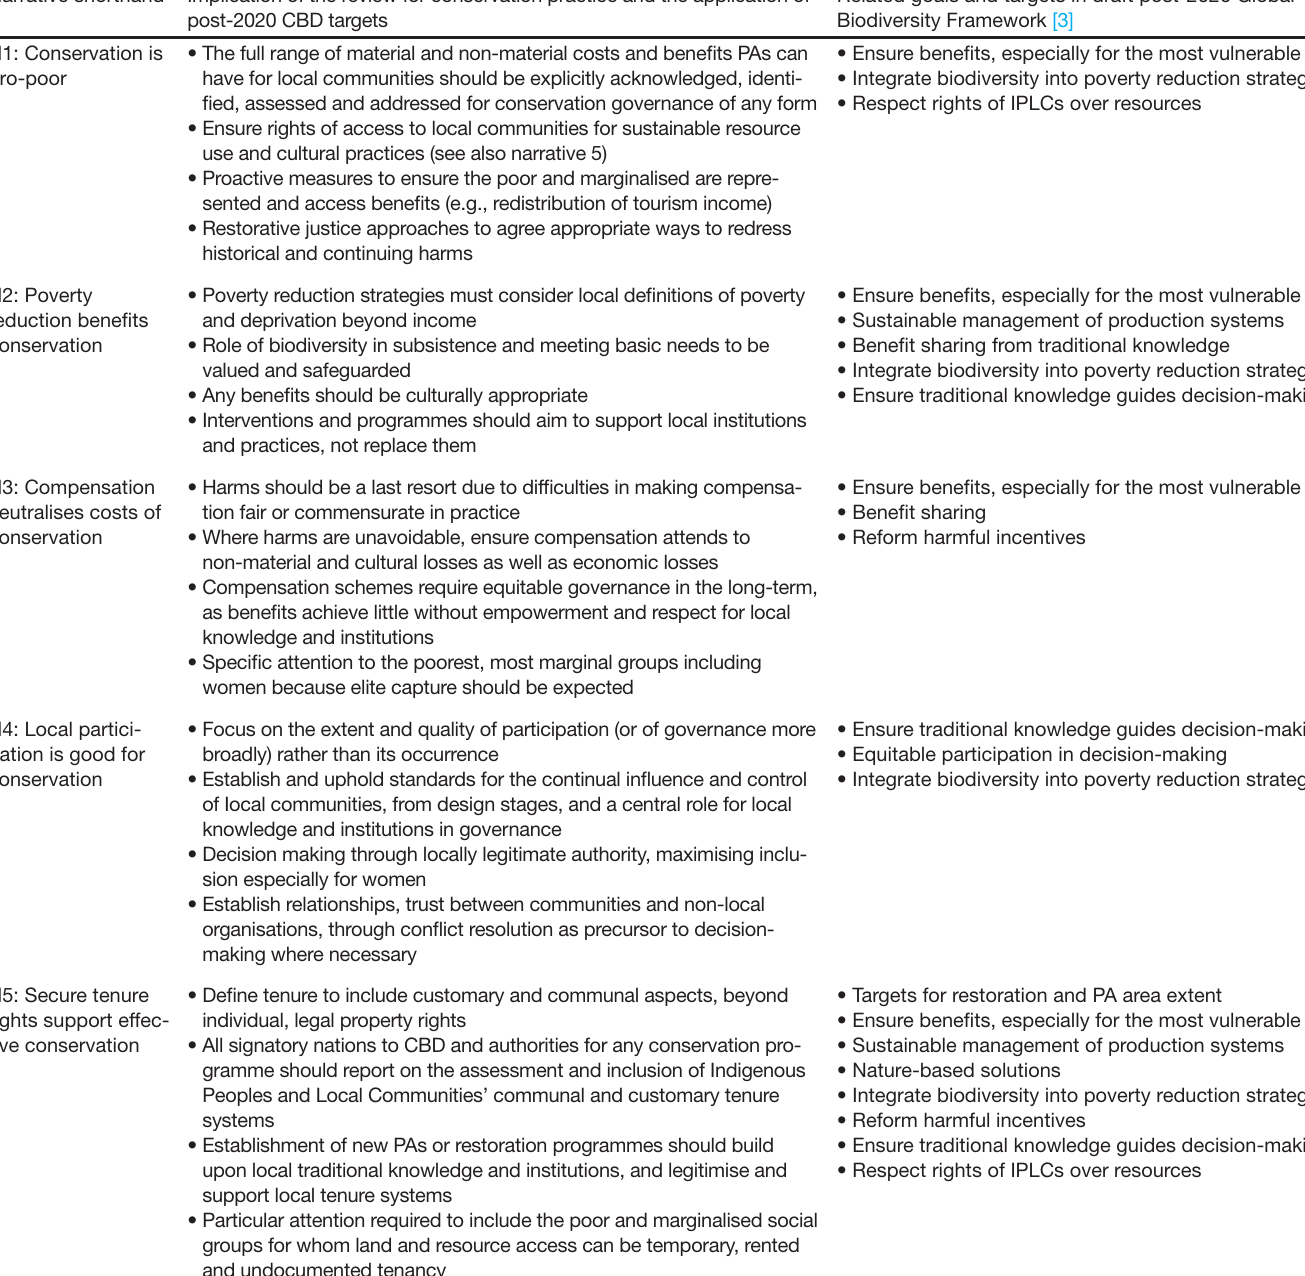
Table 2. Implications of the narrative evidence review for the application of the post-2020 Global Biodiversity Framework Narrative shorthand Implication of the review for conservation practice and the application of post-2020 CBD targets